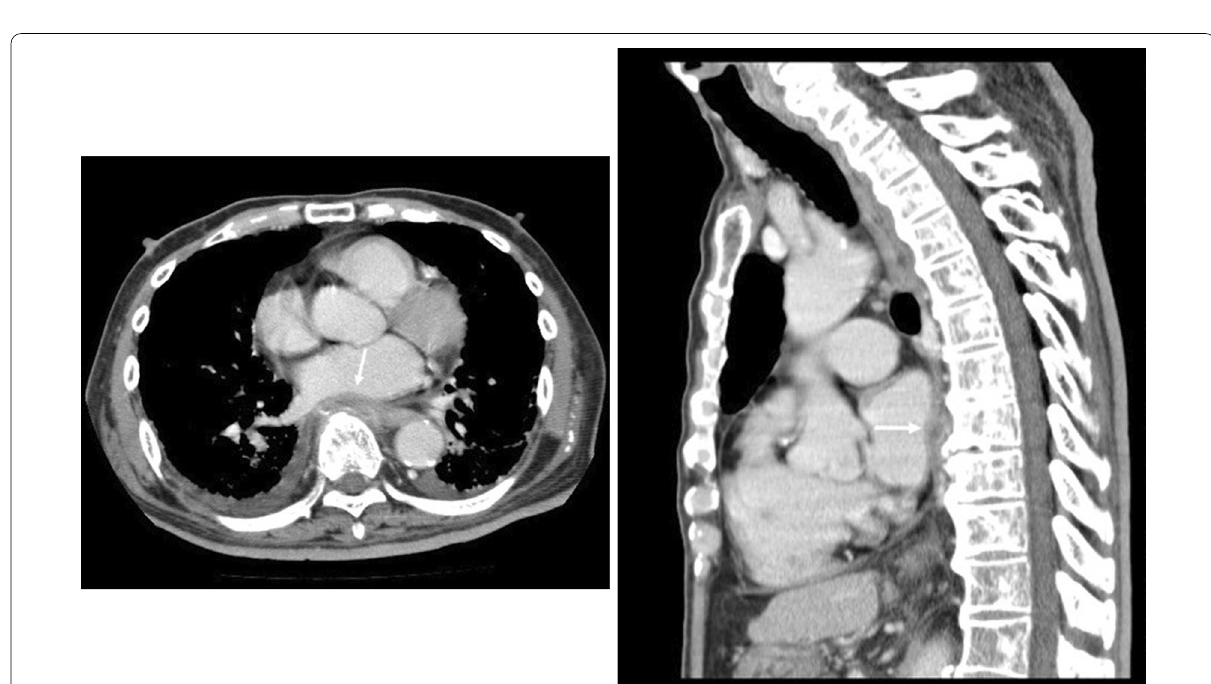
Fig. 3 Computed tomography (CT) findings of discitis. The scan shows a soft tissue shadow in front of the vertebral body extending from the 8th/9th intervertebral space